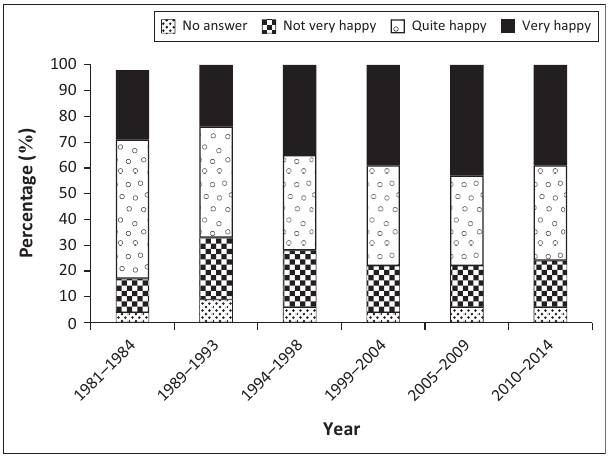
FIGURE 2: South Africans’ levels of happiness,